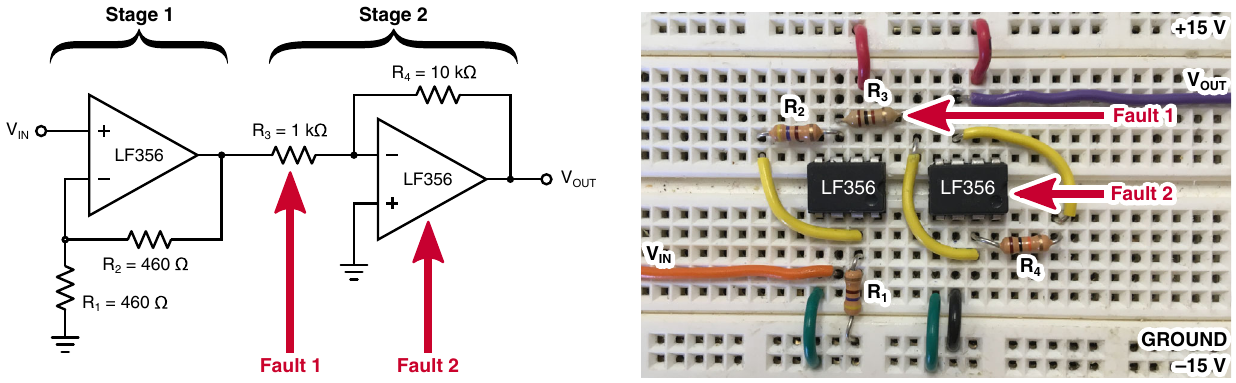
FIG. 1. (Left) Annotated schematic diagram for the inverting cascade amplifier, with design elements highlighted. Two stages were connected in series: the first stage, consisting of the leftmost op-amp and resistors R 1 and R 2 , was a non-inverting amplifier with a gain of 2; the second stage, consisting of the rightmost op-amp and resistors R 3 and R 4 , was an inverting amplifier with a gain of − 10 . The handout given to students did not include labels for stages or faults. (Right) Annotated photograph of the physical circuit. The three shown power rails were connected to (cid:1) 15 V and ground; wires connecting the circuit to power rails are not labeled. The leftmost LF365 op-amp is part of stage 1, and the rightmost is part of stage